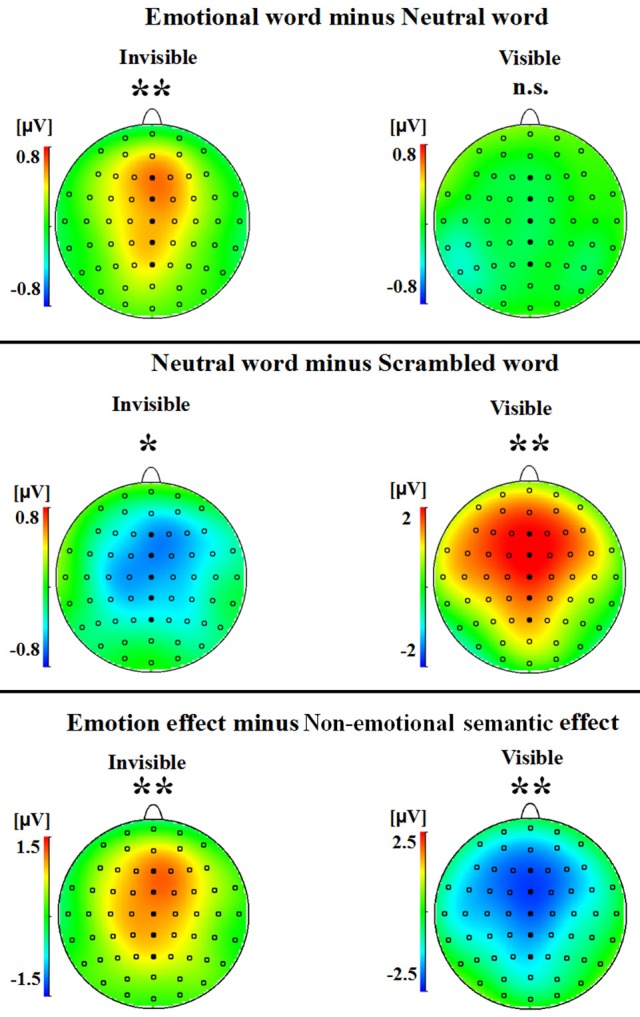
A topographical representation of the difference waves shown in Figure 2. The asterisks indicate statistical significance (n.s., not significant; *p < 0.05, **p < 0.01).